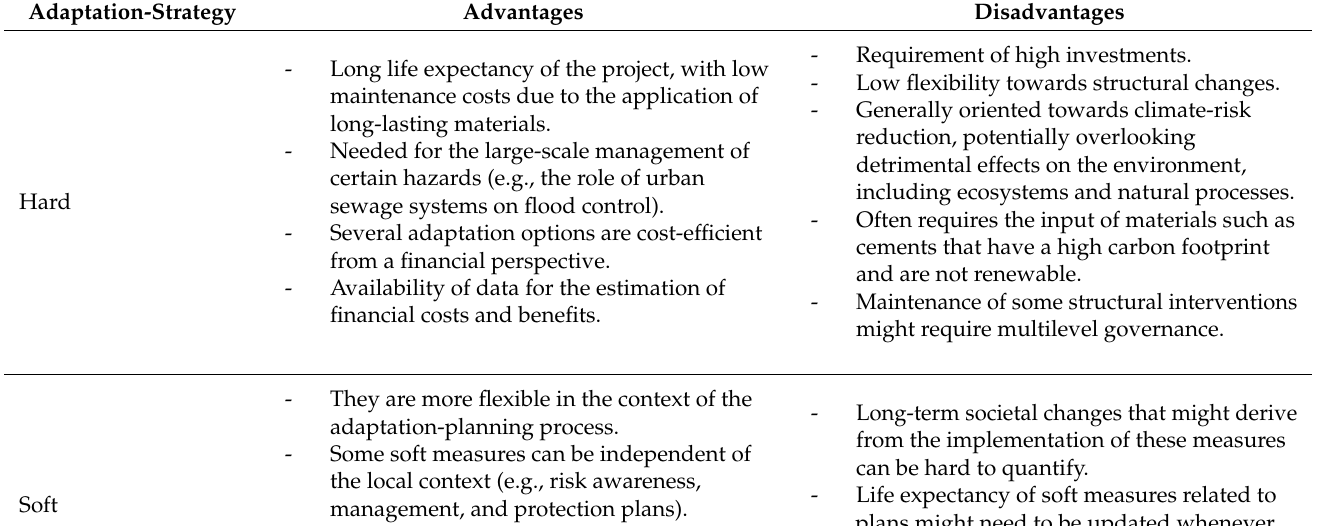
Table 8. Potential advantages and disadvantages of implementing hard, soft, and EbA